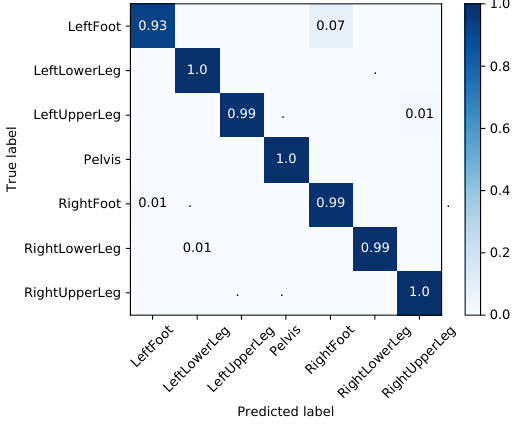
Figure 14. Evaluation results in terms of a confusion matrix for the I2S assignment problem using the final model (based on all